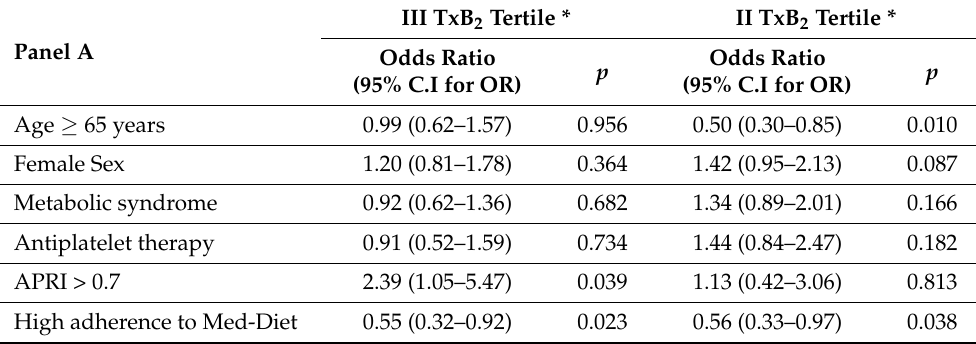
Table 3. Multivariate logistic regression analysis of factors associated TxB 2 tertiles.